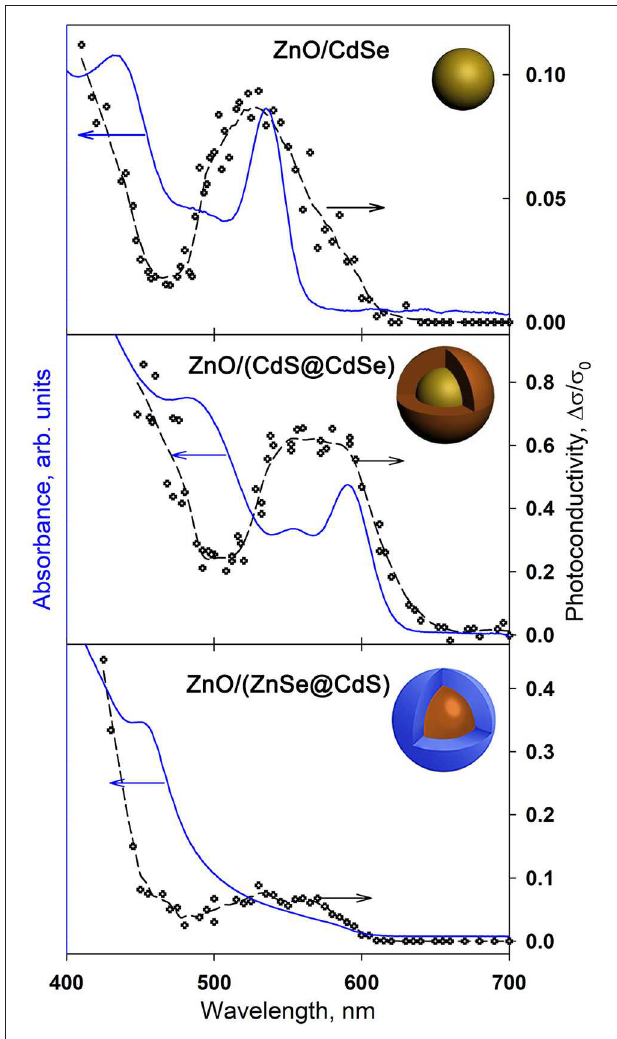
FIGURE 5 | (A) Evolution of optical absorption spectra of aliquots taken from the reaction mixture during the growth of the ZnSe shell on CdS nuclei in function of growth time (0–180min). The data are presented in the form of spectral dependence of extinction coefficient ε . Inset: Absorption spectra in semilogarithmic coordinates. (B) Evolution of luminescence spectra of aliquots taken from the reaction mixture during the growth of the ZnSe shell on CdS nuclei in function of growth time